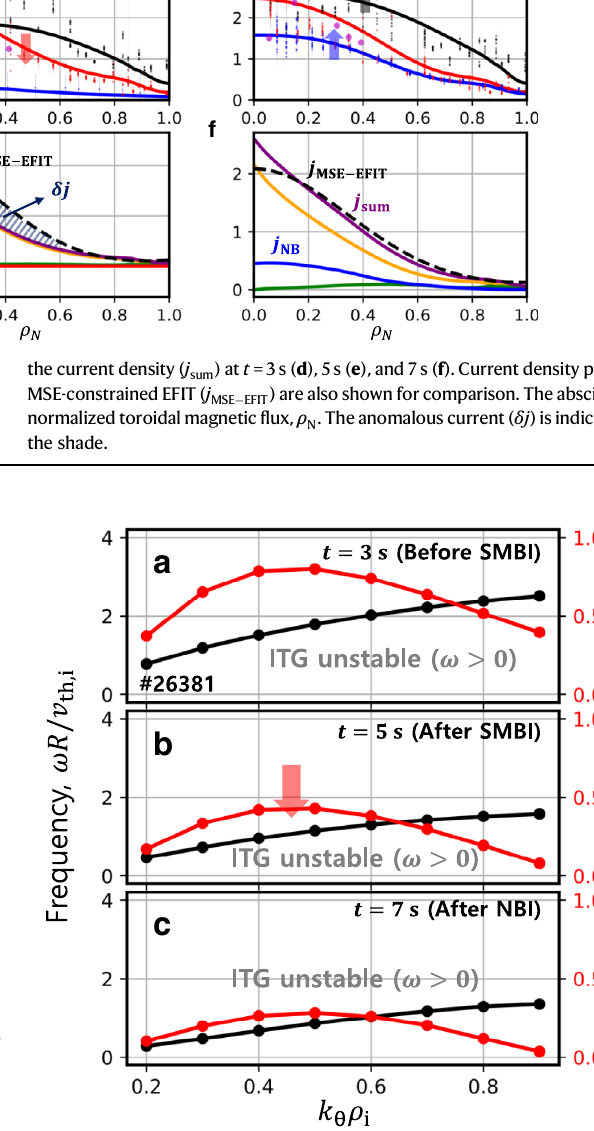
Fig. 5 | Linear gyro-kinetic analysis by GKW at ρ N =0.4 in #26381. Normalized frequency( ω R = v th,i )and growthrate( γ R = v th, i )at t =3s ( a ),5s ( b ),and7s ( c ).Here, ’ sthermalvelocity,and ω isthemodefrequency, R isthemajorradius, v th,i istheion γ is the linear growth rate of the